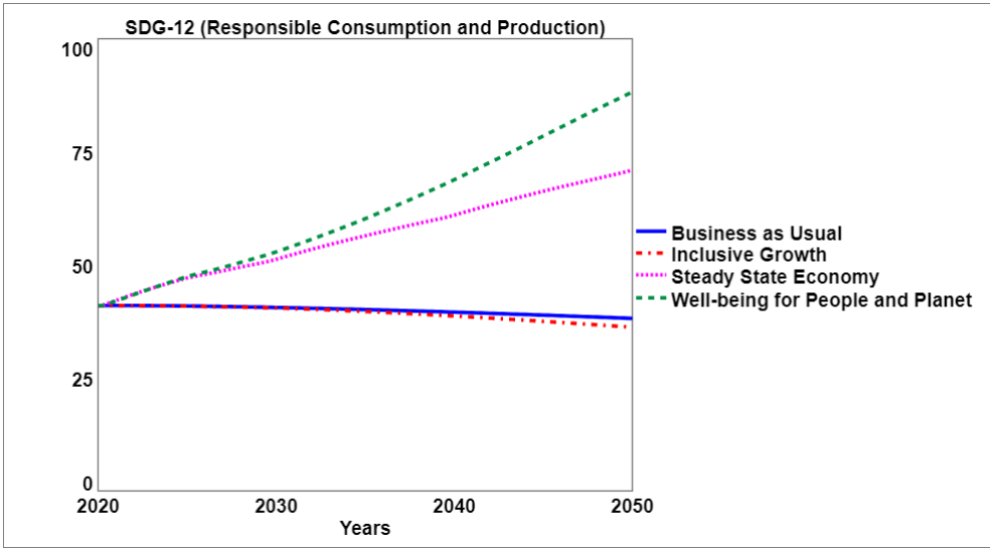
Figure 11. Implementation of SDG-12 in the four scenarios in Iran in the period 2020 to 2050.